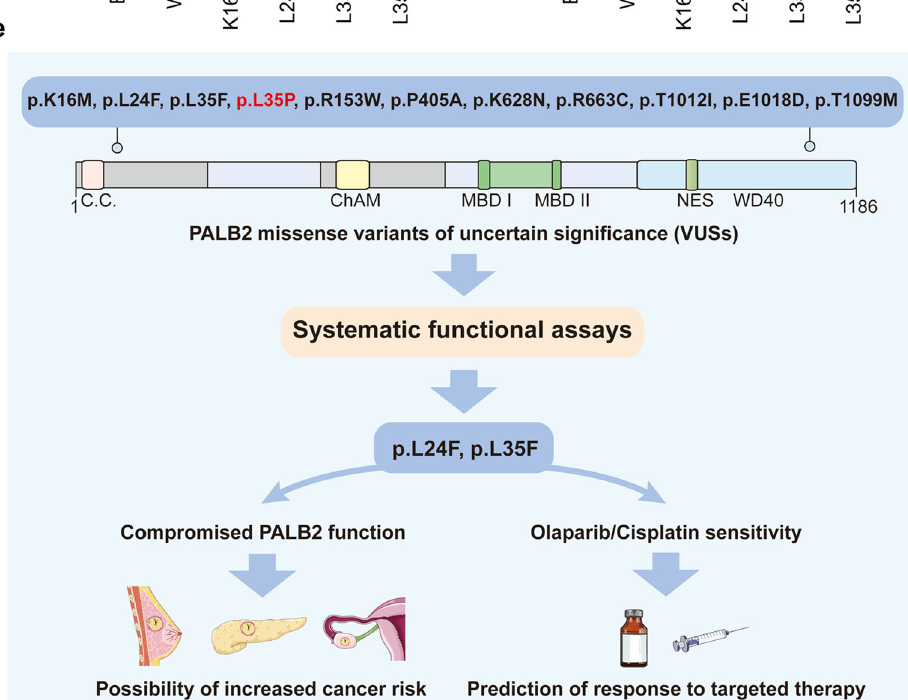
Fig. 5 Effects of PALB2 VUSs on cellular sensitivity to PARP inhibitor and cisplatin. a , b Proliferation-based survival of EUFA1341 stable cell lines after exposure to incremental doses of PARP inhibitor (olaparib) or cisplatin. Cells were incubated with drugs for 96 h. Data represent the mean percentage (± SEM) of viability relative to untreated cells from three independent experiments. Statistical signi fi cance was analyzed by one-way ANOVA and Dunnett ’ s multiple comparisons test. ** P < 0.01; **** P < 0.0001; ns Not signi fi cant. c , d Clonogenic survivals of EUFA1341 stable cell lines after exposure to olaparib or cisplatin. Cells were exposed to the indicated concentrations of olaparib (50 nM) or cisplatin (200 nM) for 10 days, after which surviving colonies were counted. Data represent the mean percentage ( ± SEM) of survival relative to the WT condition from three independent experiments. Statistical signi fi cance was analyzed by one-way ANOVA and Dunnett ’ s multiple comparisons test. **** P < 0.0001. e Schematic summary of the present fi ndings. npj Breast Cancer (2022) 86 Published in partnership with the Breast Cancer Research